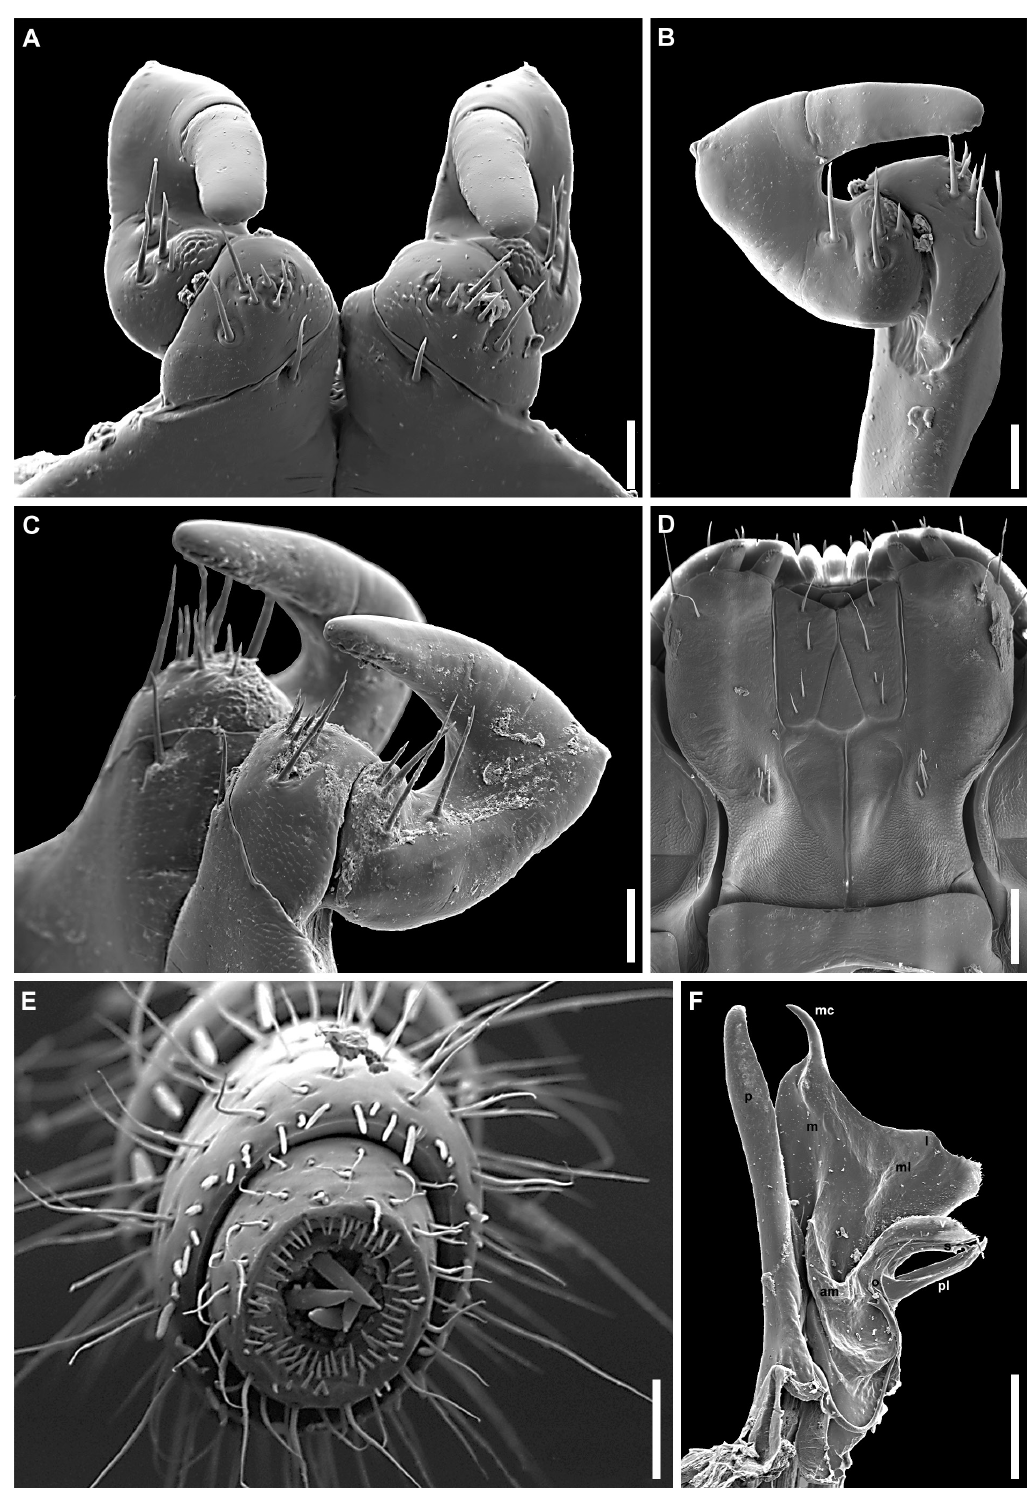
Fig. 33. Leucogeorgia prometheus sp. nov., non-type ♂ from Sataplia I Cave (ZMUM). A . Leg-pair 1, anterior view. B . Left leg 1, lateral view. C . Leg-pair 1, anterolateral view. D . Head, ventral view. E . Tip of antenna. F . Left gonopods, mesal view. Abbreviations: am = accessory membrane; f = flagellum; l = lobe; m = mesomere; mc = mesomeral claw; ml = mesomeral lamella; o = opisthomere; p = promere; pl = protective lamella; s = solenomere; v = velum. Scale bars: A–B, E = 0.05 mm; C–D, F = 0.2